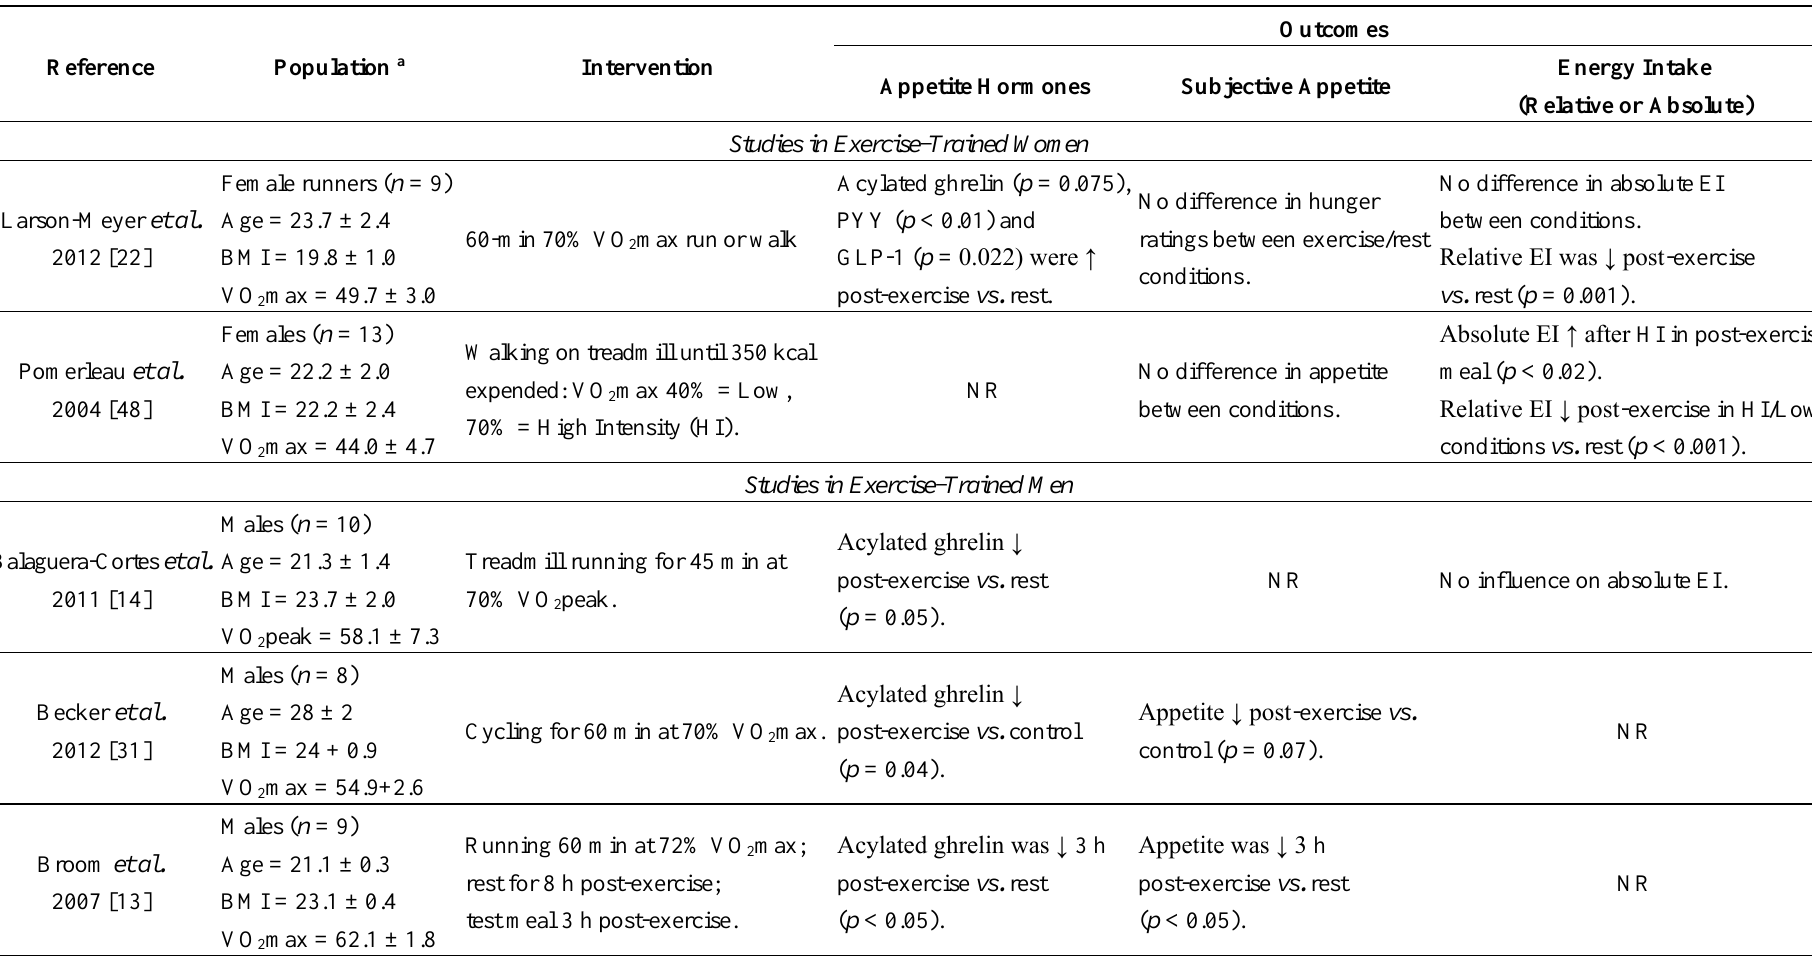
Table 2. Studies examining the effect of acute aerobic exercise on subjective and objective appetite and energy intake in exercise-trained individuals.